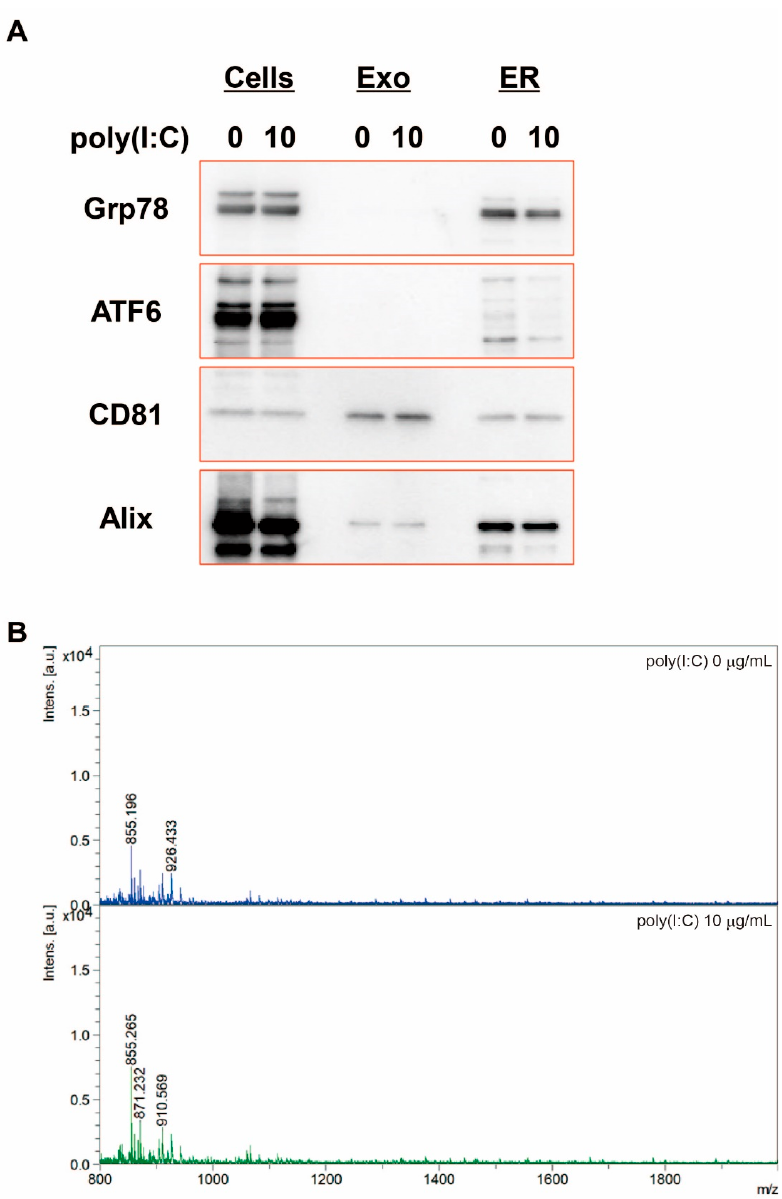
Figure 5. Exosomes do not contaminate the ER fraction from HEK-Blue hTLR3 cells. ( A ) Western blot analysis of markers for the ER and exosomes (Exo) fractions from HEK-Blue hTLR3 cells in the presence or absence of poly(I:C). ( B ) The ER fraction from HEK-Blue hTLR3 cells after poly(I:C) treatment was analyzed by MALDI-TOF MS.